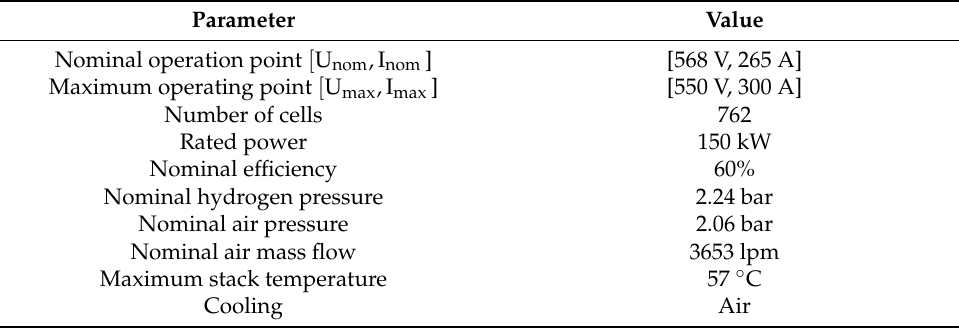
Table 2. PEMFC specifications.